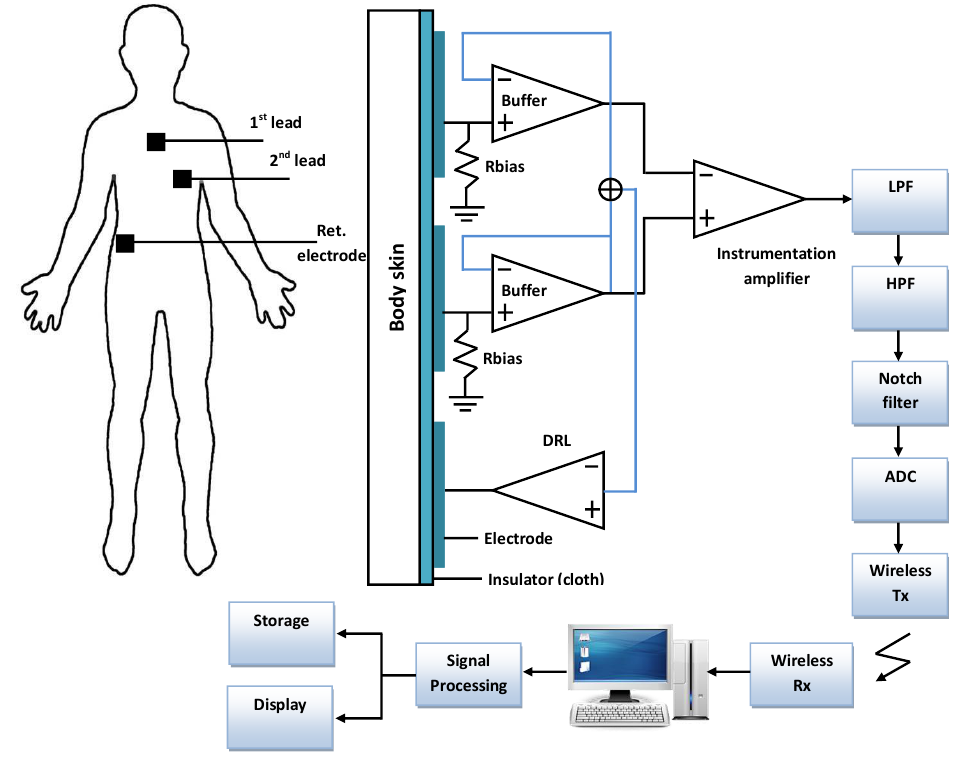
Figure 4. ECG probe placement and measurement devices [45].